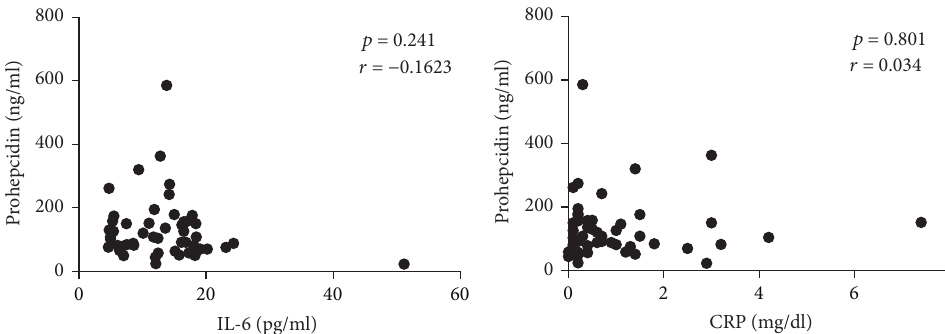
Figure 7: Correlation between IL-6 and CRPversus prohepcidin in CD patients. Statistical analysis was performed using Pearson’s correlation